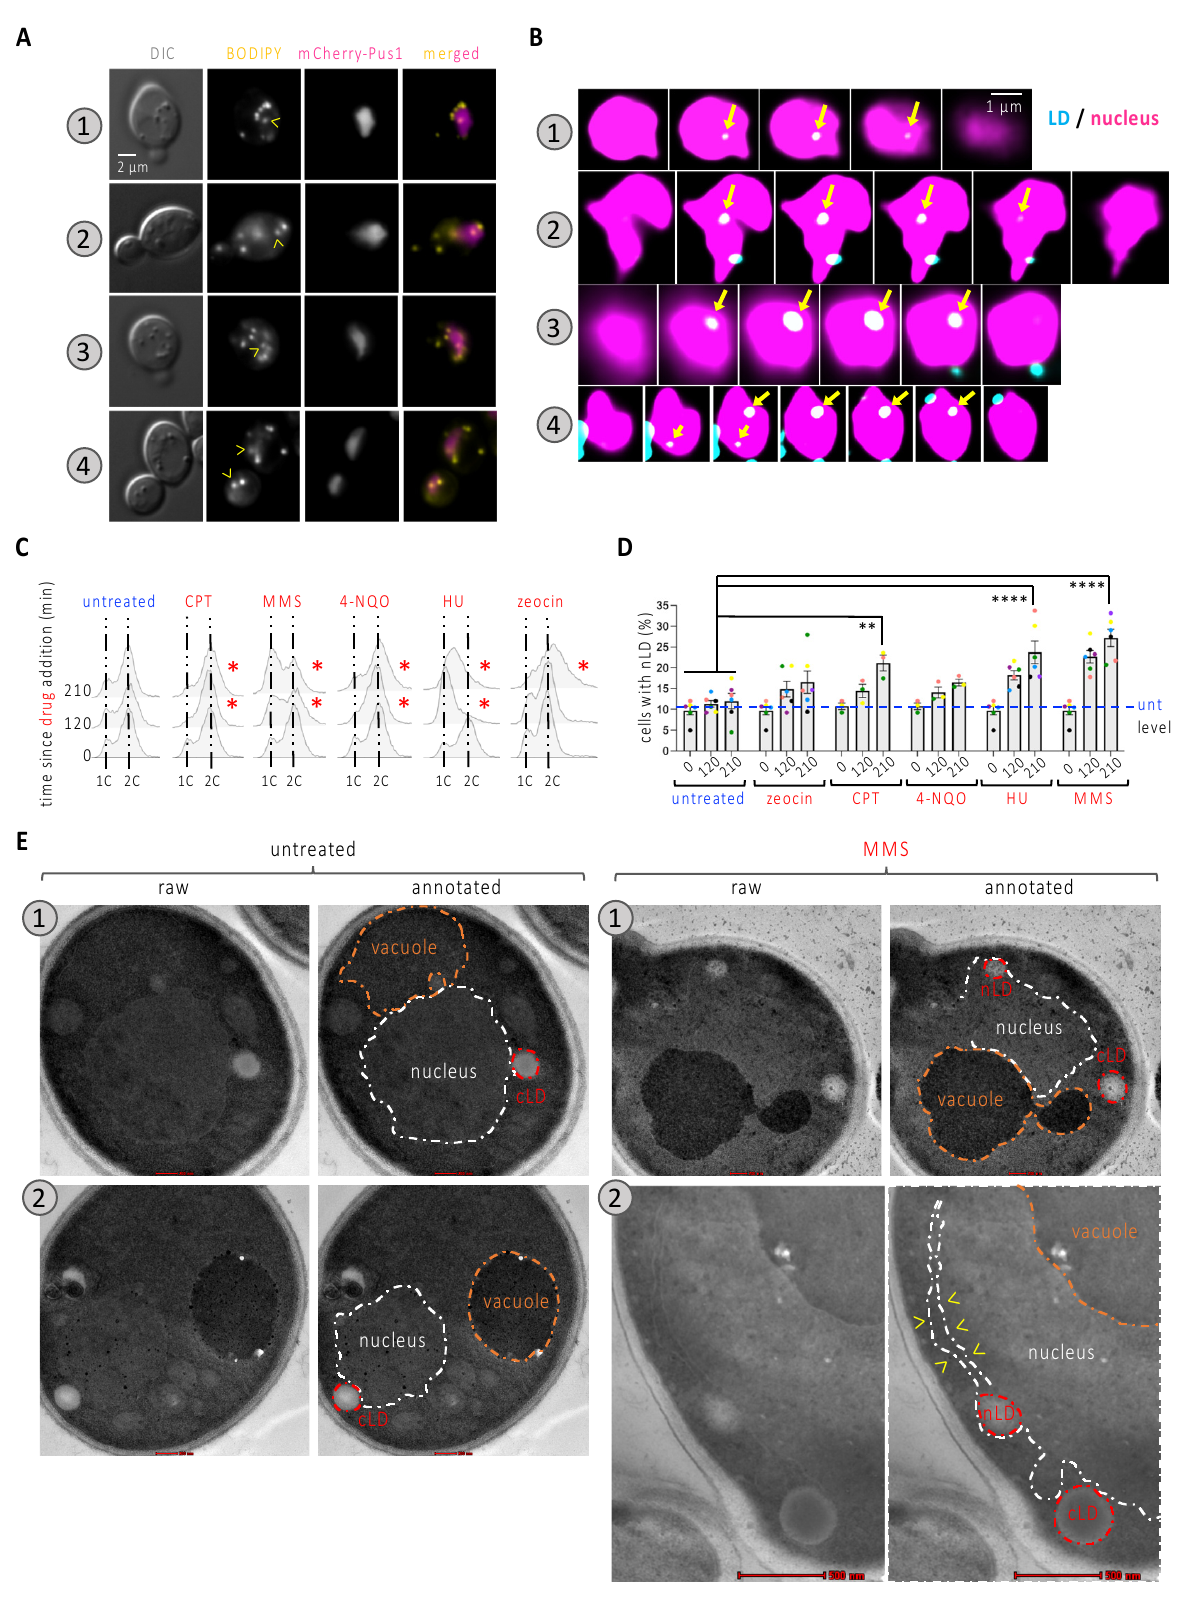
Figure 1. Characterization of nLD occurrence in response to genotoxins. ( A ) Cells expressing the mCherry-tagged Pus1 nucleoplasmic protein were also stained with BODIPY to dye LD. Arrow- heads point at LD colocalizing with the nucleus. Numbers refer to 4 different examples. ( B ) Through-focus series were acquired every 200 nm across nuclei; images treated with Huygens soft- ware and consecutive slices are presented to illustrate the inclusion of the indicated LD fully within the nucleus (arrows). ( C ) Cytometry analysis of exponentially growing WT cells that were exposed to the indicated treatments for the indicated times. Delays as compared to the untreated condition